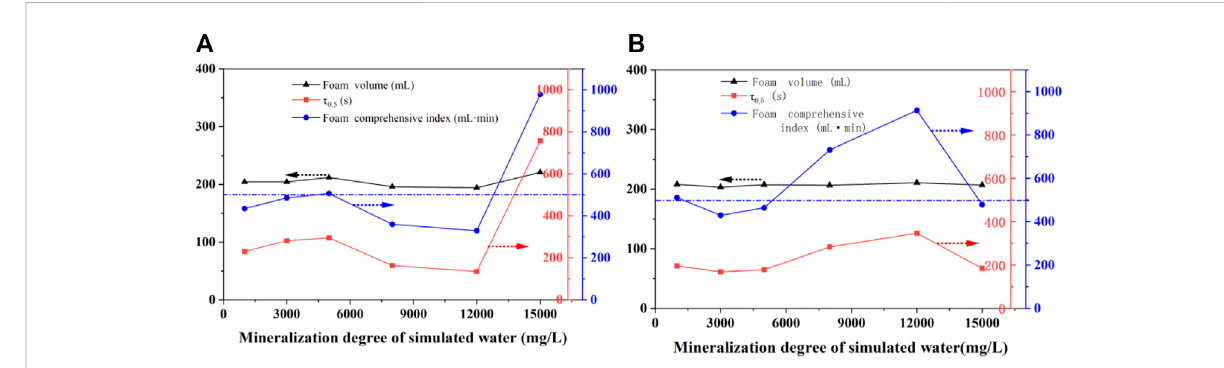
FIGURE 10 Effect of mineralization degree on the foam performance of a 2# foaming system without (A) and with (B)